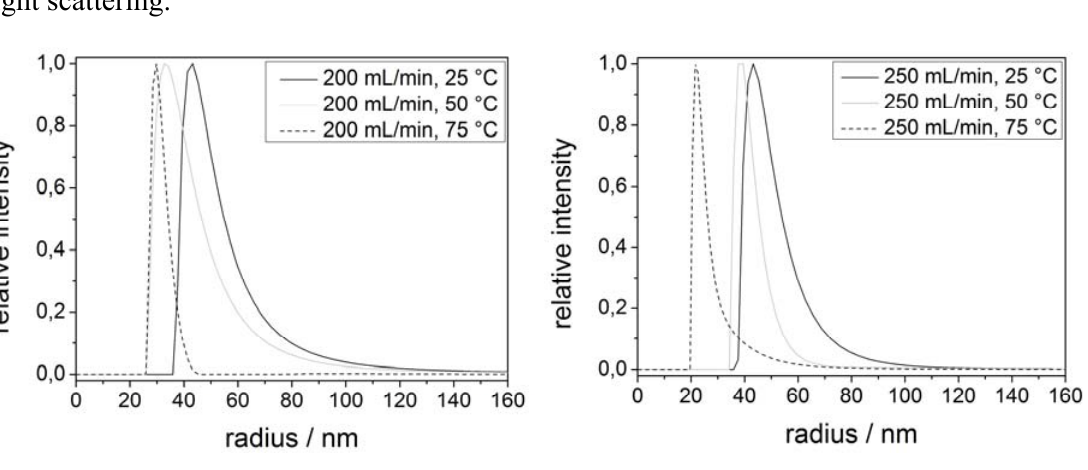
Figure 4. Particle sizes of the obtained zinc oxide particles determined by dynamic light scattering.